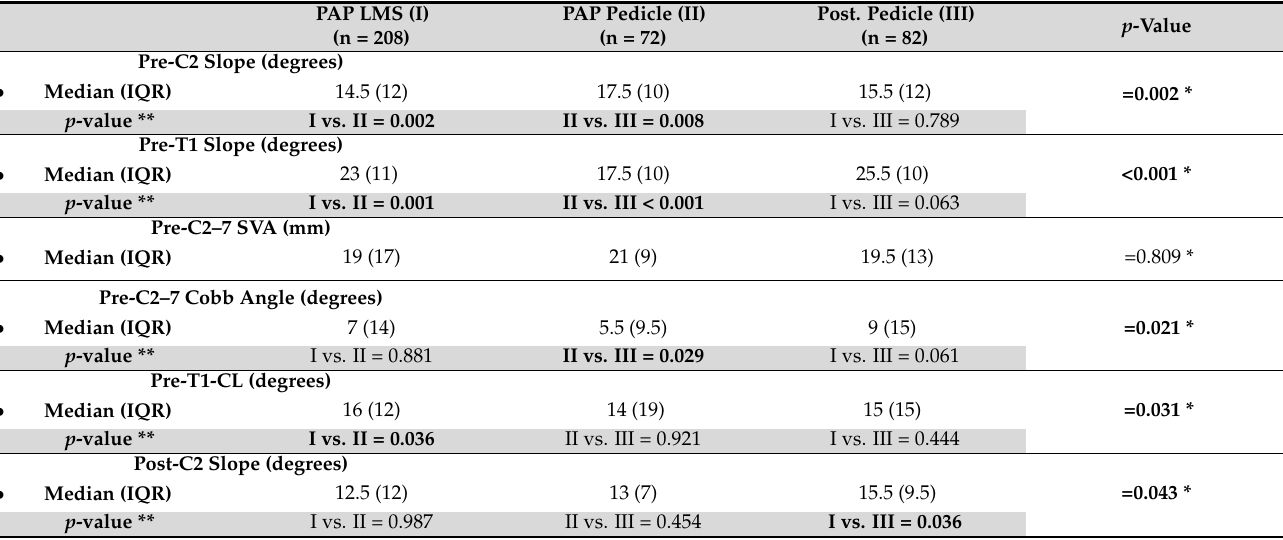
Table 2. Cervical lordosis parameters in the studied